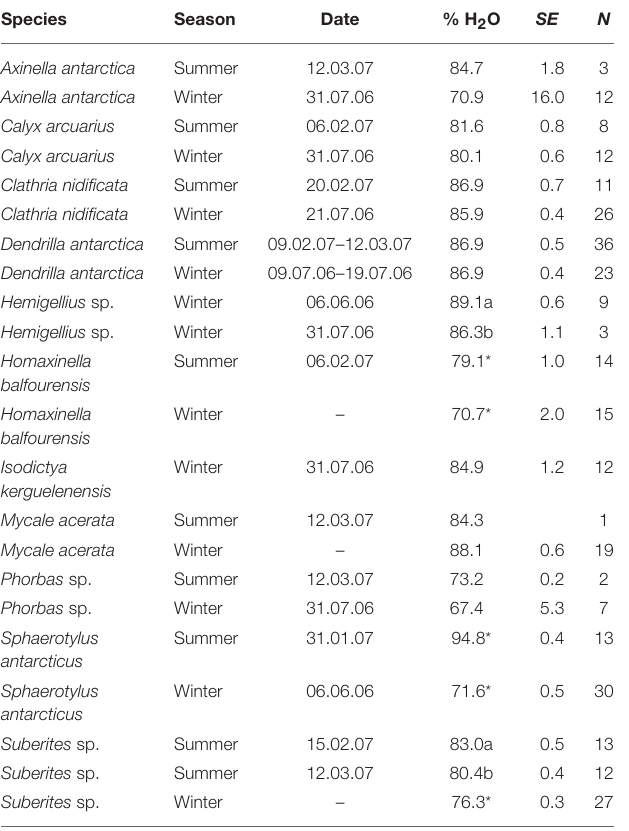
TABLE 1 | The % water content of sponge species in summer and winter. Species